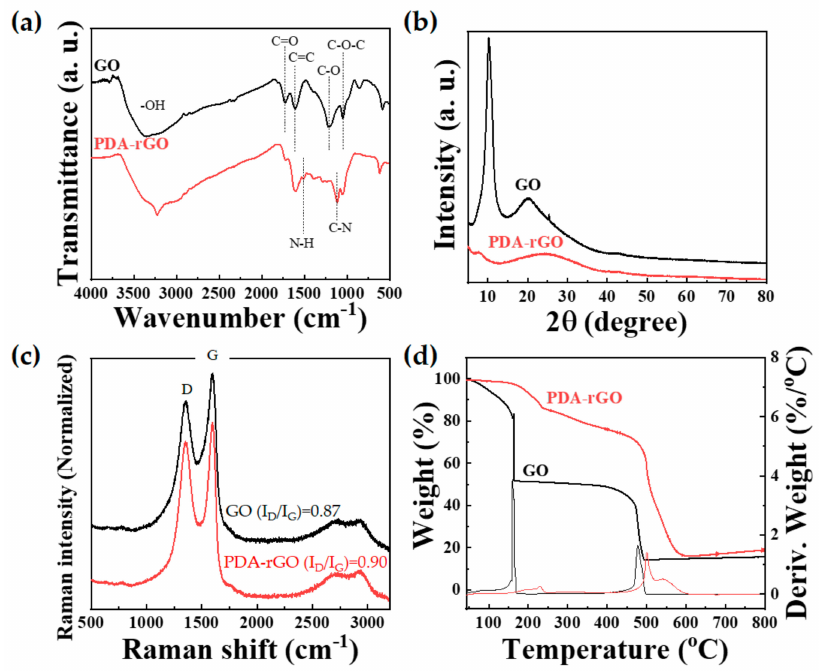
Figure 3. ( a ) FTIR spectra, ( b ) XRD patterns, ( c ) Raman spectra, and ( d ) TGA curves of graphene oxide (GO) and